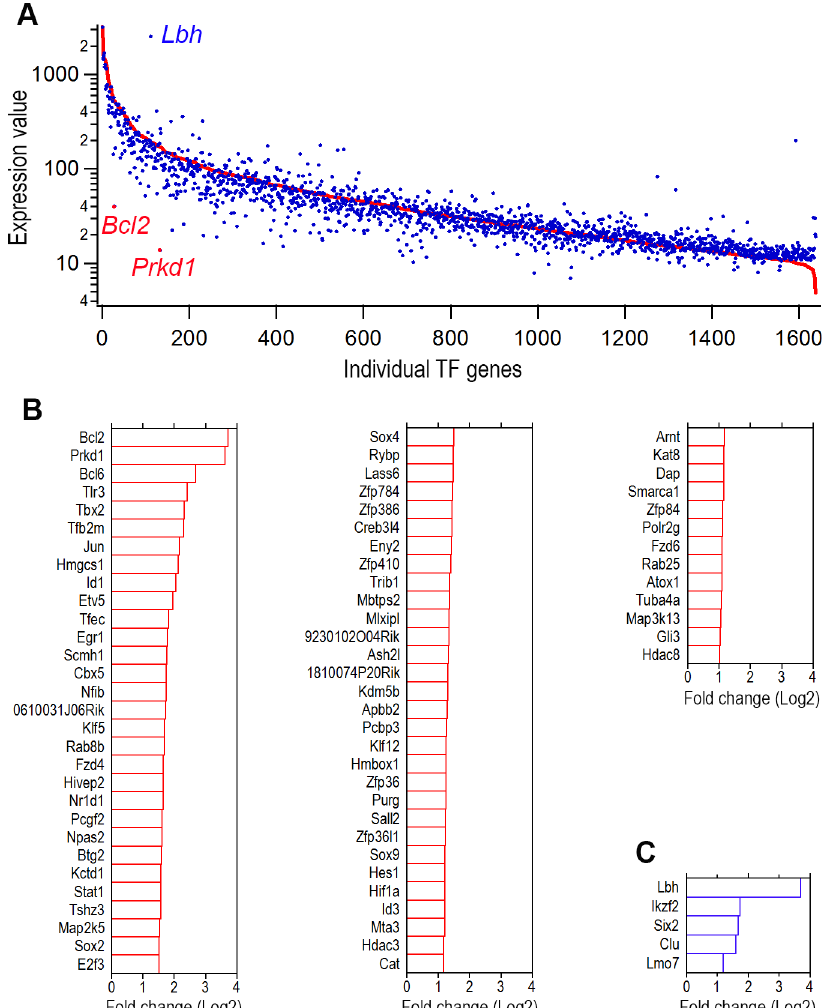
Fig 3. Differentially and uniquely expressed TF genes in adult IHCs and OHCs. (A) All TF genes in IHCs and OHCs. The red line represents the expression level of all individual TF genes of IHCs while each blue dot represents the expression level of the same TF genes in OHCs. TF genes that are differentially expressed in OHCs are above the red line while genes that are differentially expressed in IHCs are below the red line. (B) Differentially expressed IHC TF genes with reference to the expression of same genes in OHCs (in Log 2 ). (C) Differentially expressed adult OHC TF genes with reference to the expression of the same genes in IHCs. Only those whose expression levels differ by at least one Log 2 -fold between the two populations of cells are shown in B and C.